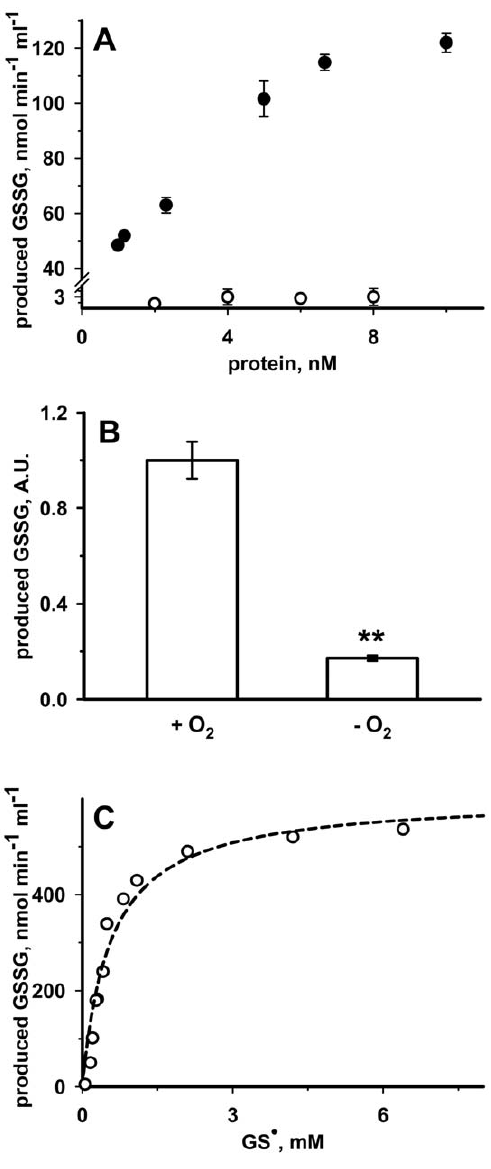
Figure 7. GS N -scavenging activity of RhdA. Initial rates of the RhdA-mediated production of glutathione disulphide (GSSG) in the presence of GS N were spectrophotometrically ( l = 340 nm; e =6220 M 2 1 cm 2 1 ) determined by measuring the NADPH consumed in the glutathione oxido-reductase coupled reaction. Reactions were carried out in 50 mM sodium-phosphate buffer (pH 7.4) at 25 u C. ( A ) GSSG production in the presence of various concentrations of RhdA (full circles) and RhdA-Cys 230 (empty circles) is reported. ( B ) GS N -scavenging activity of 16 nM RhdA in the absence ( 2 O 2 ) of oxygen is reported relatively to that in standard conditions ( + O 2 ) taken as unitary. A. U., arbitrary units. ( C ) Michaelis-Menten of GS N -scavenging activity of RhdA. Best non-linear fit to experimental data is showed (dashed